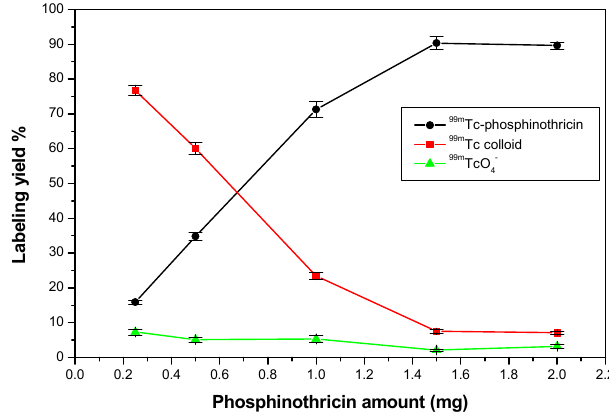
Figure 8 . Radiochemical yield of 99m Tc-phosphinothricin as a function of phosphinothricin amount. Reaction conditions: 10 µg of SnCl 2 ·2H 2 O, 100 µL (7.2 MBq) of 99m TcO 4 − solution, at a pH 8 for 15 min.